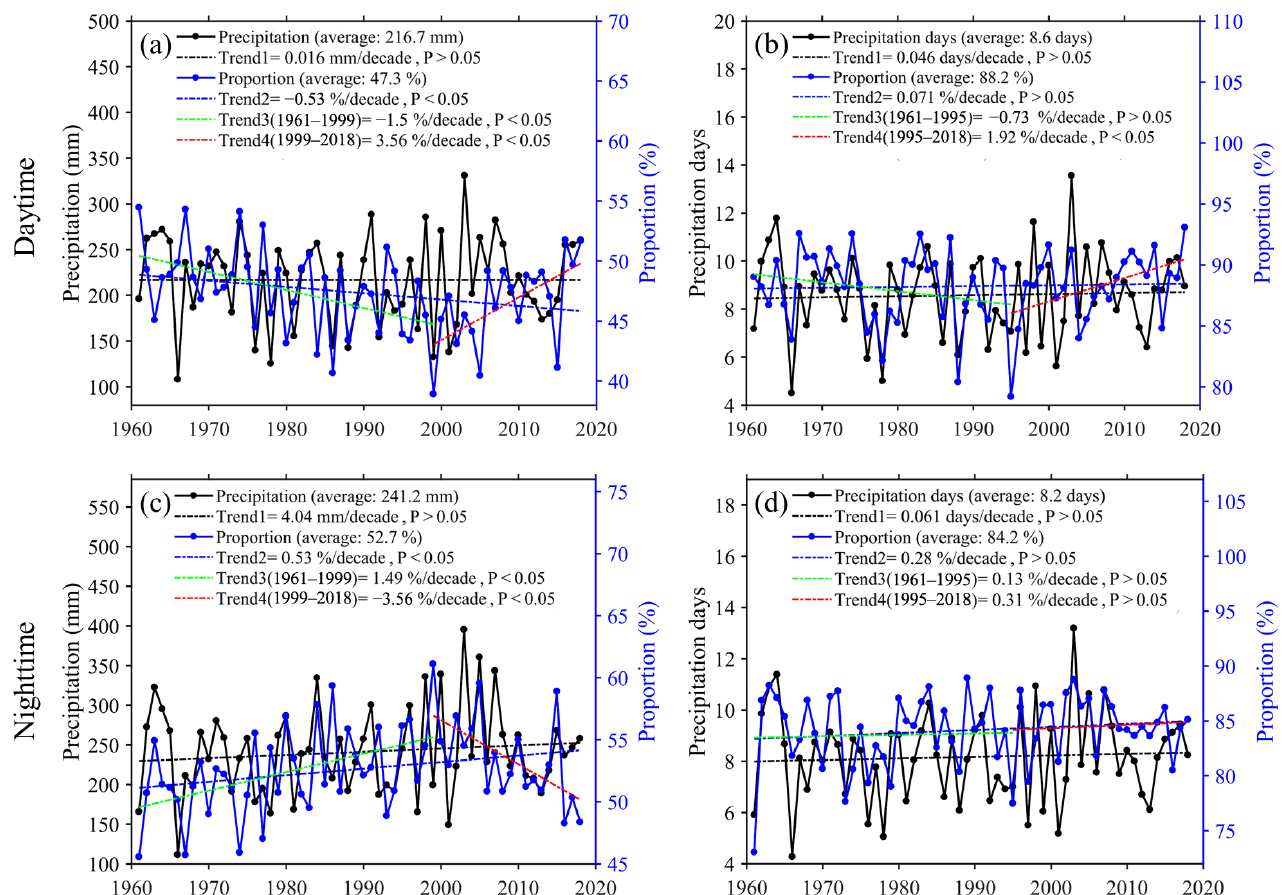
Figure 13. ( a ) Daytime precipitation under TR90p conditions and its proportion of TR90p. ( b ) Number of precipitation days under TR90p conditions and the proportion of TR90p. ( c ) Nighttime precipitation under TR90p conditions and its proportion of TR90p. ( d ) Number of precipitation nights under TR90p conditions and the proportion of TR90p.